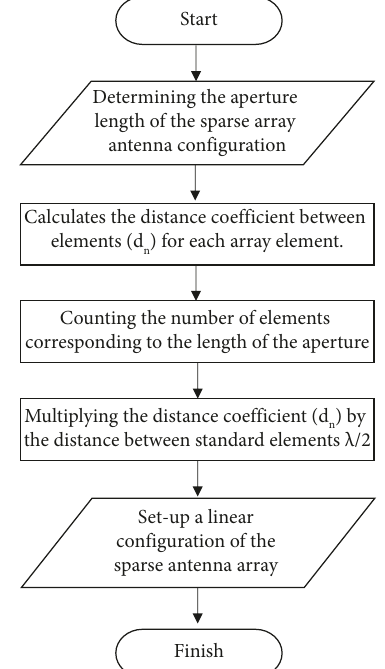
Figure 2: Flowchart proposed design method.